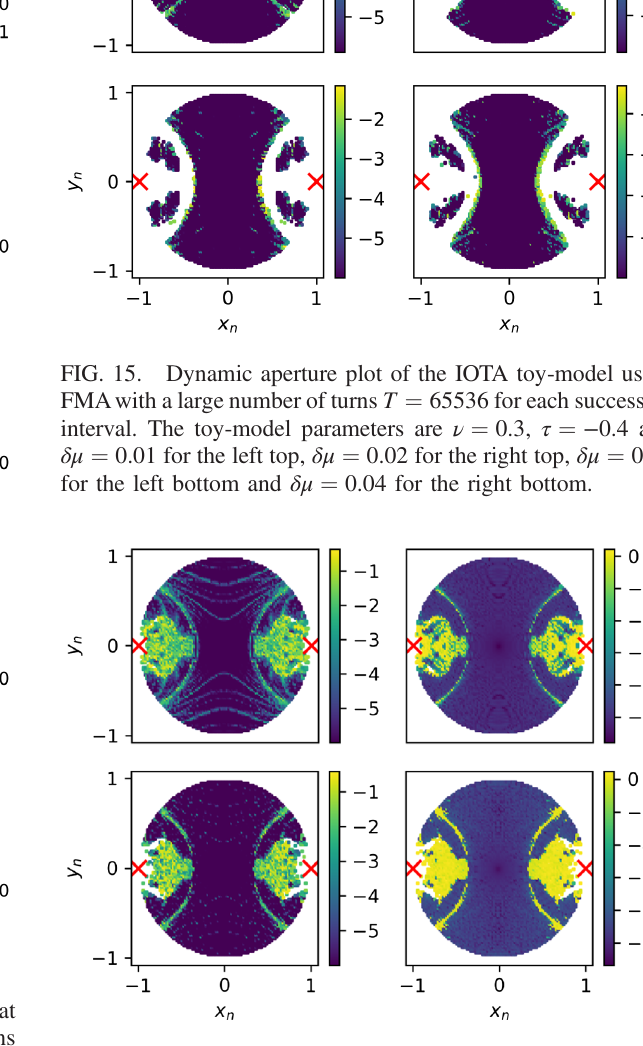
T ¼ 2048 . This suggests that such fine microstructures